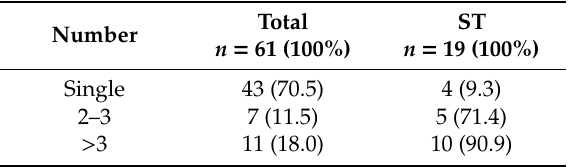
Abbreviations: ST-sclerosis